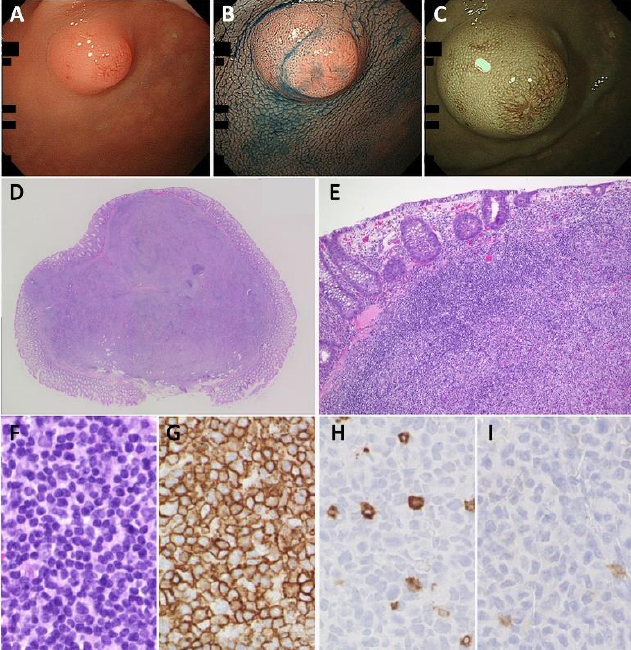
Figure 3. Rectal-mucosa-associated lymphoid tissue (MALT) lymphoma. ( A , B ) Endoscopic images showing a 10 mm solitary elevated lesion with erosion on the surface. ( C ) Narrow band imaging showing enlarged vessels on the surface of the lesion. ( D ) Specimen from endoscopic mucosal resection. ( E , F ) Monotonous proliferation of small- to intermediate-sized centrocyte-like cells observed. ( G – I ) The tumor cells are positive for CD20 ( G ) and negative for CD5 ( H ) and CD10 ( I ). Original magnification: ×100 ( E ) and ×400 ( F – I ).